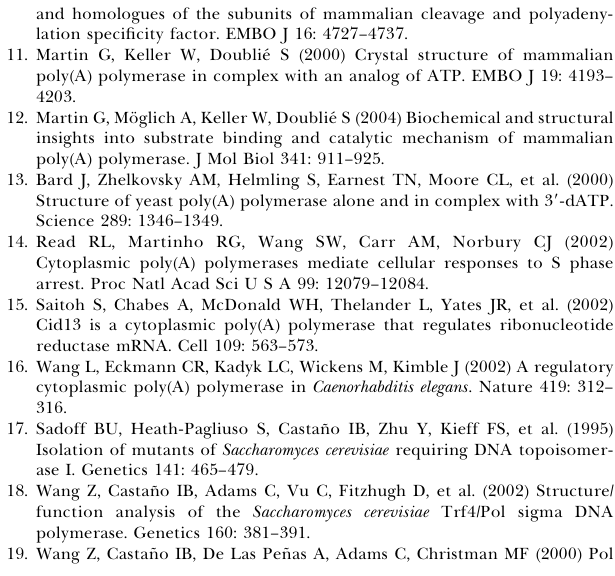
Figure S1. Native tRNA iMet Can Be Polyadenylated by the Activity of Recombinant Yeast Pap1p and Eubacterial PAP Polyadenylation activity of Pap1p, Trf4p-TAP, and E. coli PAP (Eco- PAP) on native and unmodified tRNA iMet . The 5 9 -end-labeled tRNAs were incubated with 50 ng of Trf4 complex, 50 ng of Pap1p, or 50 ng of E. coli PAP for the times indicated and separated on a 10% gel. The migration position of the input tRNA is indicated by an arrow. Lane I on each gel contained input tRNA alone. Found at DOI: 10.1371/journal.pbio.0030189.sg001 (871 KB PDF). Figure S2. Composition and Activity of the Rrp6-TAP Complex (A) Polypeptide composition of the affinity-purified TAP-tagged Rrp6p (Rrp6-TAP). The purification was done as described in Materials and Methods, and a sample was separated by 12% SDS- PAGE and stained with silver. The predicted position of Rrp6p is indicated by an arrow. (B) Rrp6p-TAP eluates contain residual amounts of Mtr4p. Western blot analysis of Rrp6-TAP with antibodies directed against Mtr4p, Trf4p, and the C-terminus of the TAP-tag. Affinity-purified fractions of Mtr4p (Mtr4-TAP) were used as a control. (C) The Rrp6p-TAP complex alone does not efficiently degrade unmodified tRNA iMet . The 5 9 -end-labeled in vitro transcribed tRNA iMet was incubated with 100 ng of Rrp6p-TAP complex in the presence of 1 mM ATP (lanes 2–5) or without ATP (lanes 6–9). Reactions were stopped after 10, 30, 60, or 120 min by the addition of one volume of formamide loading buffer and analyzed by electro- phoresis on a 15% gel. The position of the input RNA is indicated by an arrow. Figure S3. The Rrp6p-TAP Complex Has 3 9 to 5 9 Exonuclease Activity In vitro transcribed tRNA iMet was polyadenylated with recombinant yeast Pap1p; the polyadenylated products were eluted from poly- acrylamide gel and labeled at their 3 9 ends with a - 32 P cordycepin triphosphate (3 9 dATP, NEN). The poly(A)-tRNA iMet was then incubated with 100 ng of Rrp6p-TAP complex (lanes 2–6) or with buffer A (lanes 7–11) for 2, 15, 30, 45, or 60 min, stopped by the addition of one volume of formamide loading buffer, and analyzed by electrophoresis on a 15% gel. Found at DOI: 10.1371/journal.pbio.0030189.sg003 (750 KB PDF). Figure S4.